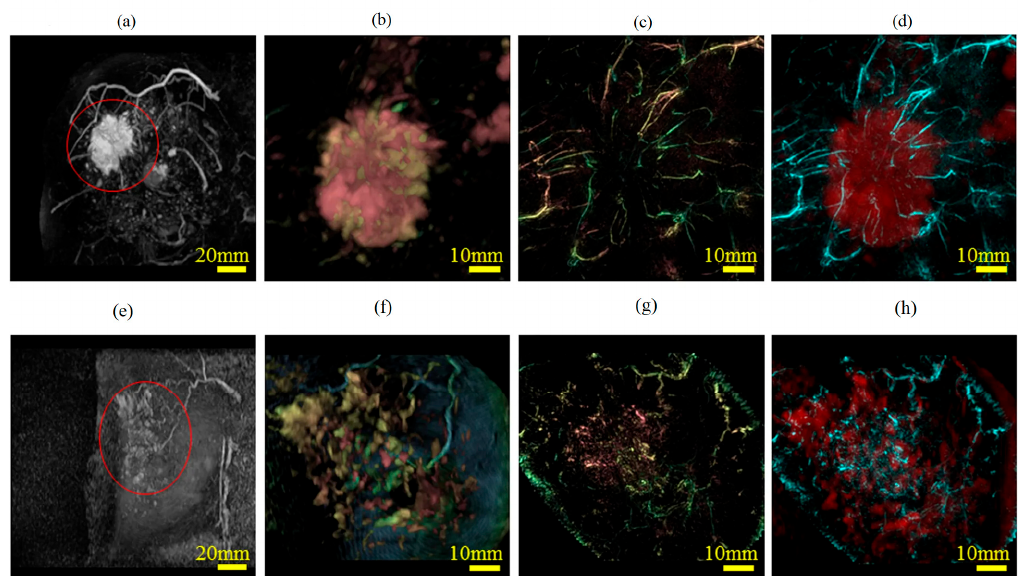
Figure 5. Example of MR, PA and their fusion images of two cases. Case 1 ( a – d ): A 40-year-old woman with IBC. Case 2 ( e – h ): A 46-year-old woman with DCIS in upper-outer area in right breast. ( a , e ) Original MR image, lesion is indicated by a red circle; ( b , f ) the enlarged MR images around the lesion after deforming into the shape to PA images; ( c , g ) and ( d , h ) are original PA images, and fusion images of PA (cyan) and MR (red), respectively; these figures are after eliminating the PA signals from subcutaneous blood vessels by a depth of 4 mm. Reproduced from Toi et al. [39], which is licensed under a Creative Commons Attribution 4.0 (http://creativecommons.org/licenses/by/4.0/).